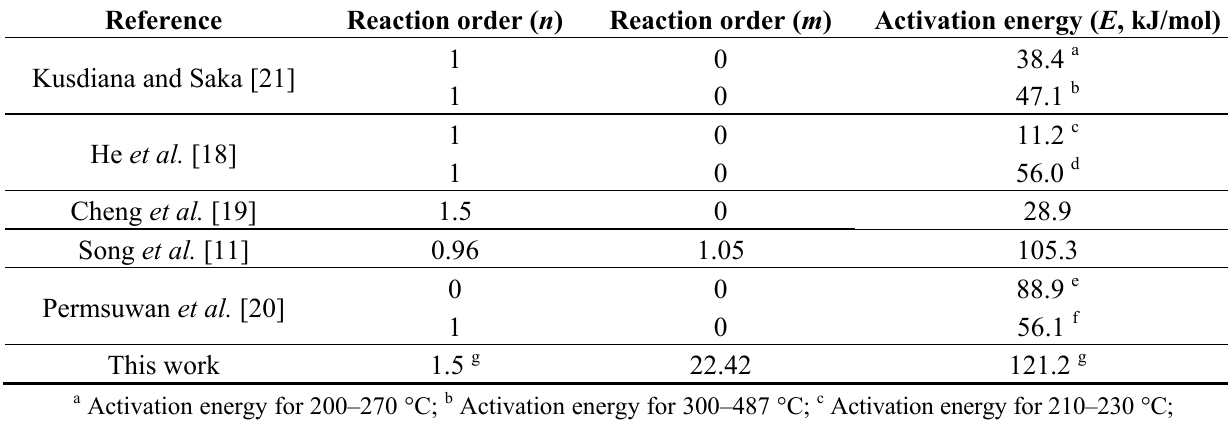
Table 3. Comparison of kinetic parameters in this work with